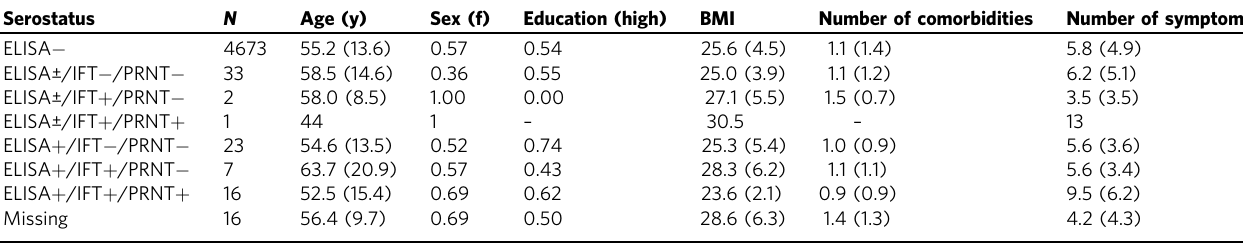
Table 1 Sample characteristics (Group I) strati fi ed by serostatus.